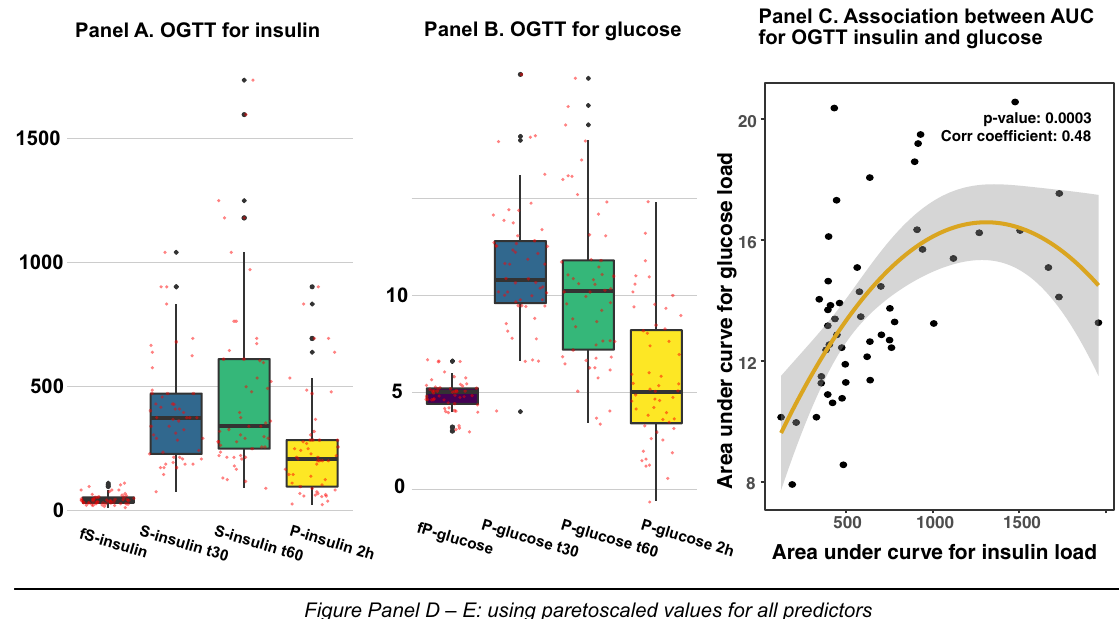
Figure Panel D – E: using paretoscaled values for all predictors